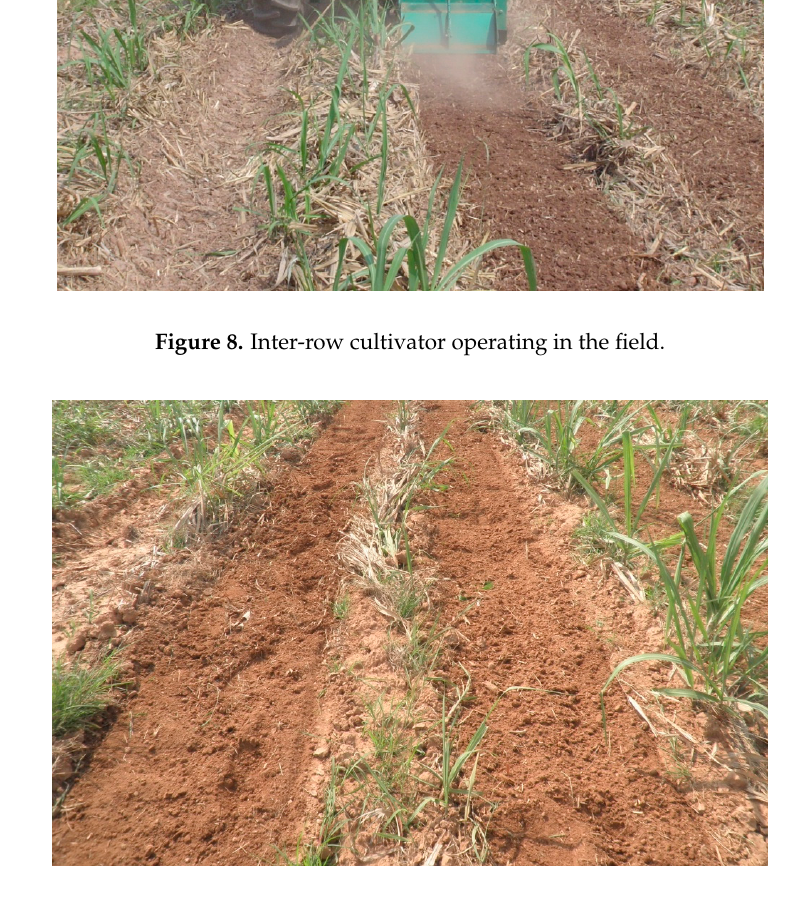
Figure 9. Sugarcane residues after being mixed into the soil by the inter-row cultivator.